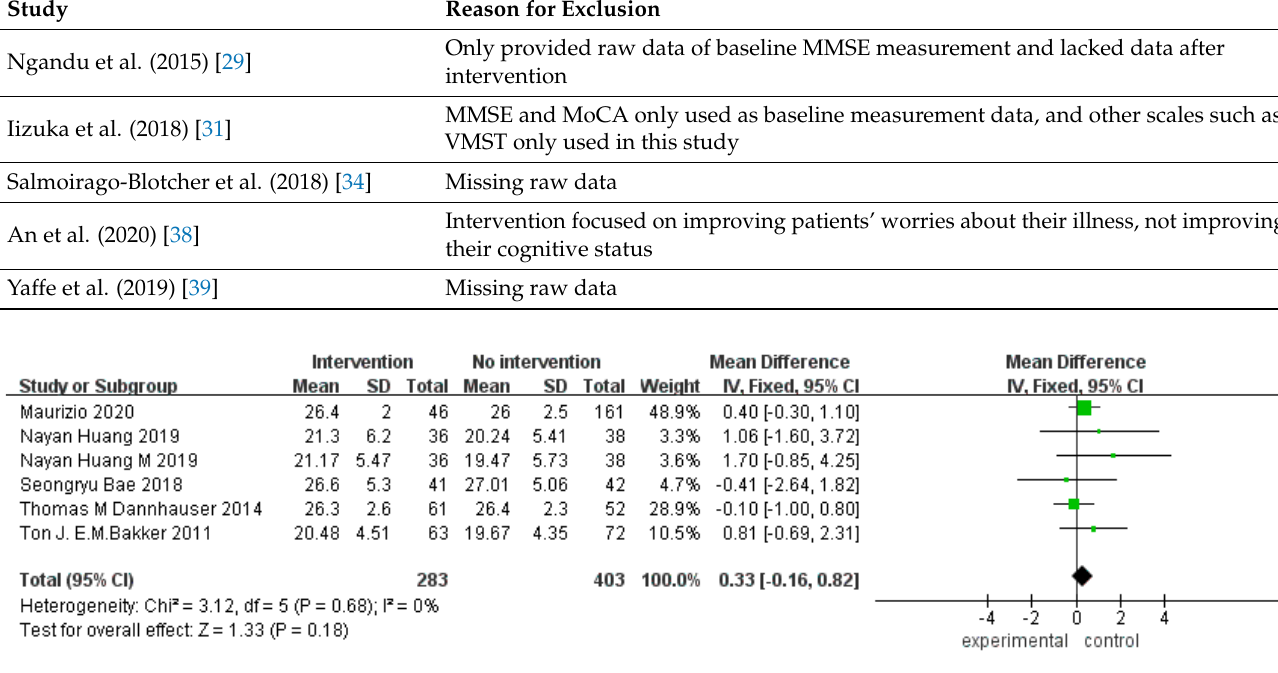
Figure 3. Forest plot of MMSE scale for overall cognitive function improvement [30,32,35,37,40].